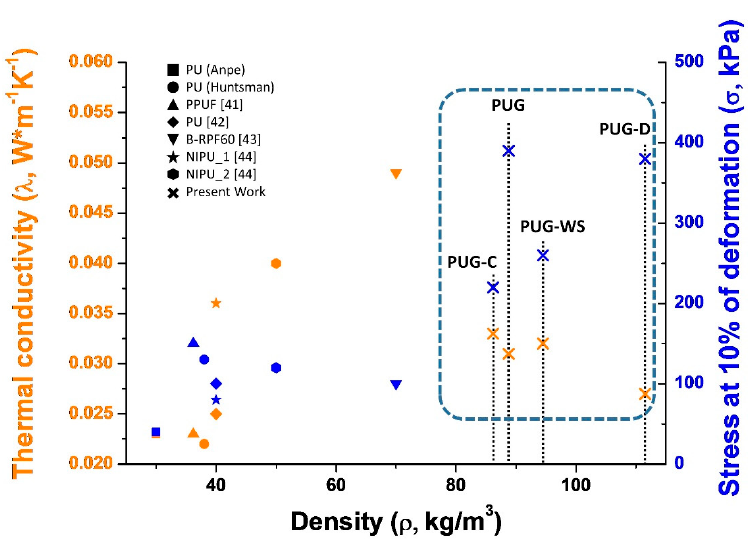
Figure 7. Comparison of density, thermal conductivity and mechanical properties of selected Polyurethane foams.